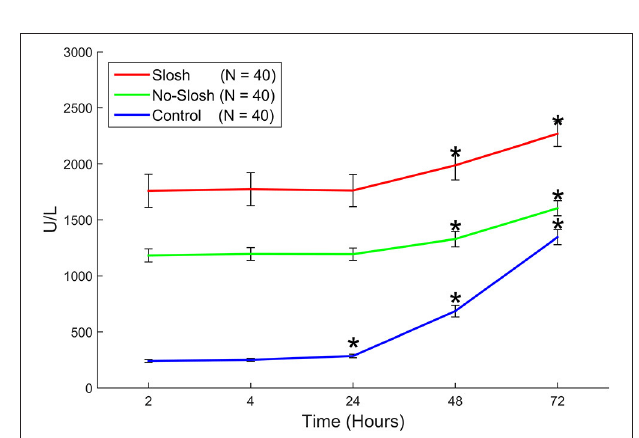
FIGURE 4 | (A) Image of final blast chamber and nail gun being positioned over a CO 2 cartridge (B) Underside of final blast chamber underside showing access to the CO 2 blasted cartridge.